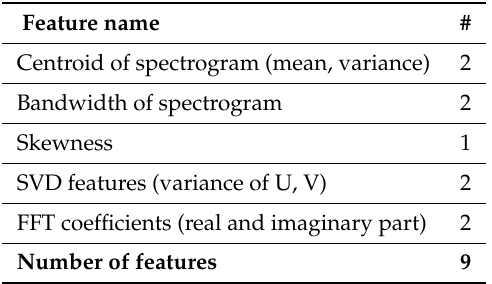
Table 7. Most robust features from the feature selection of 5